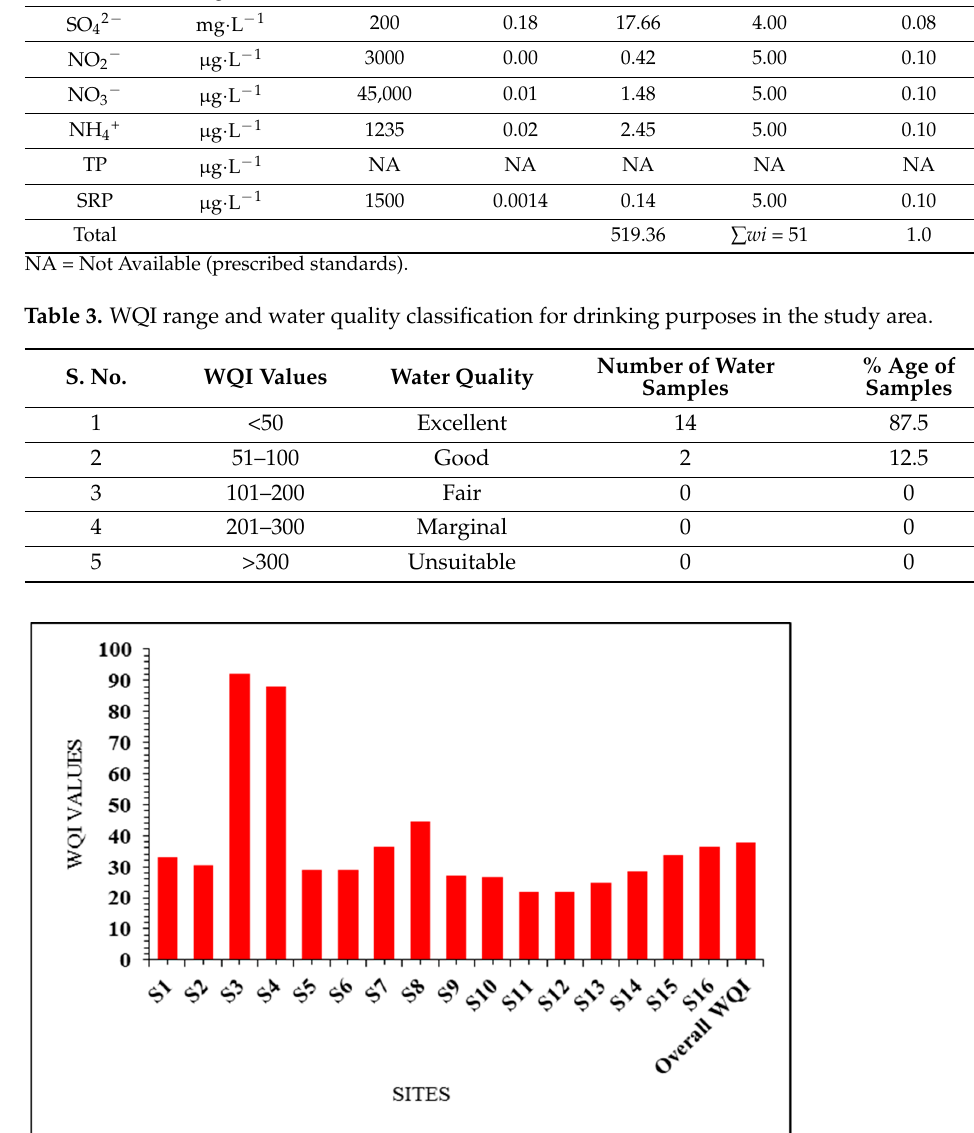
Figure 3. Results of water quality index (WQI) for drinking purposes for the different springs and drilled well water